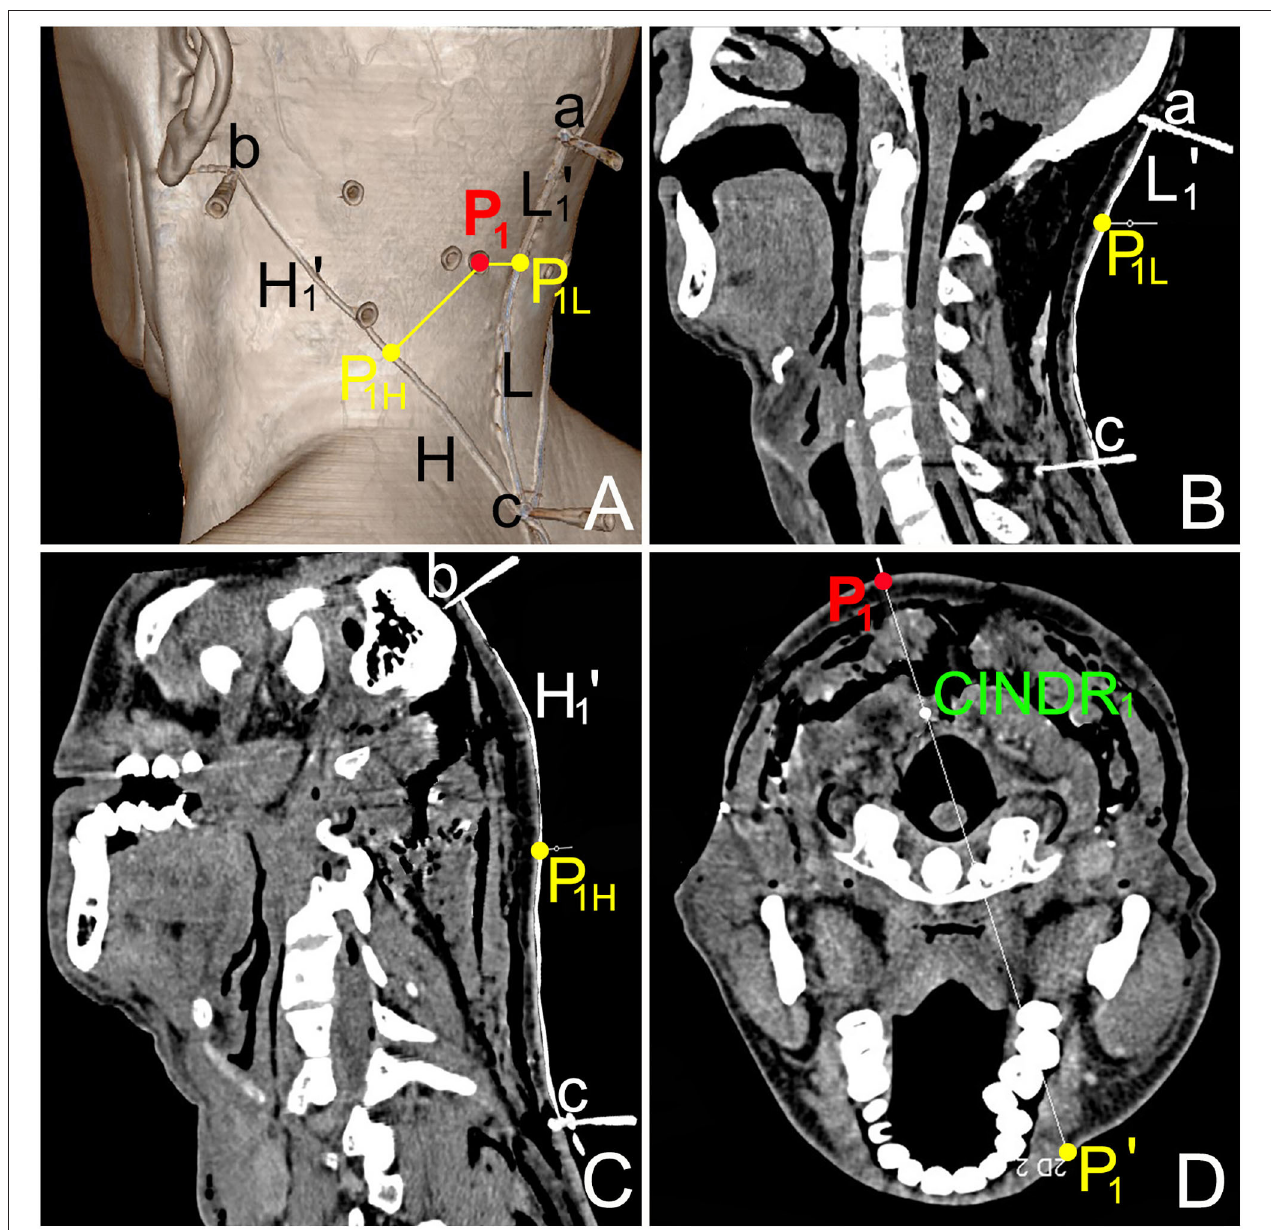
FIGURE 3 | CT images of the center of intramuscular nerve dense region (CINDR 1 ) of left rectus capitis posterior minor. (A) Spiral CT three-dimensional reconstruction image shows the body surface projection position and design reference line of the CINDR. Point a is the external occipital protuberance, point b is the mastoid process, and point c is the spinous process of the 7th cervical spine. P 1 is the body surface projection point of CINDR 1 of rectus capitis posterior minor. ac line = L reference line, a-P 1L = L 1 ’; bc = H reference line, and b-P 1H = H 1 ’. (B) The length of the L reference line and L 1 ’ line on the sagittal section through the ac line. (C) The length of the H reference line and H 1 ’ line on the cross-section passing through the bc line. (D) The depth of CINDR 1 , measured on the cross-section through P 1 .